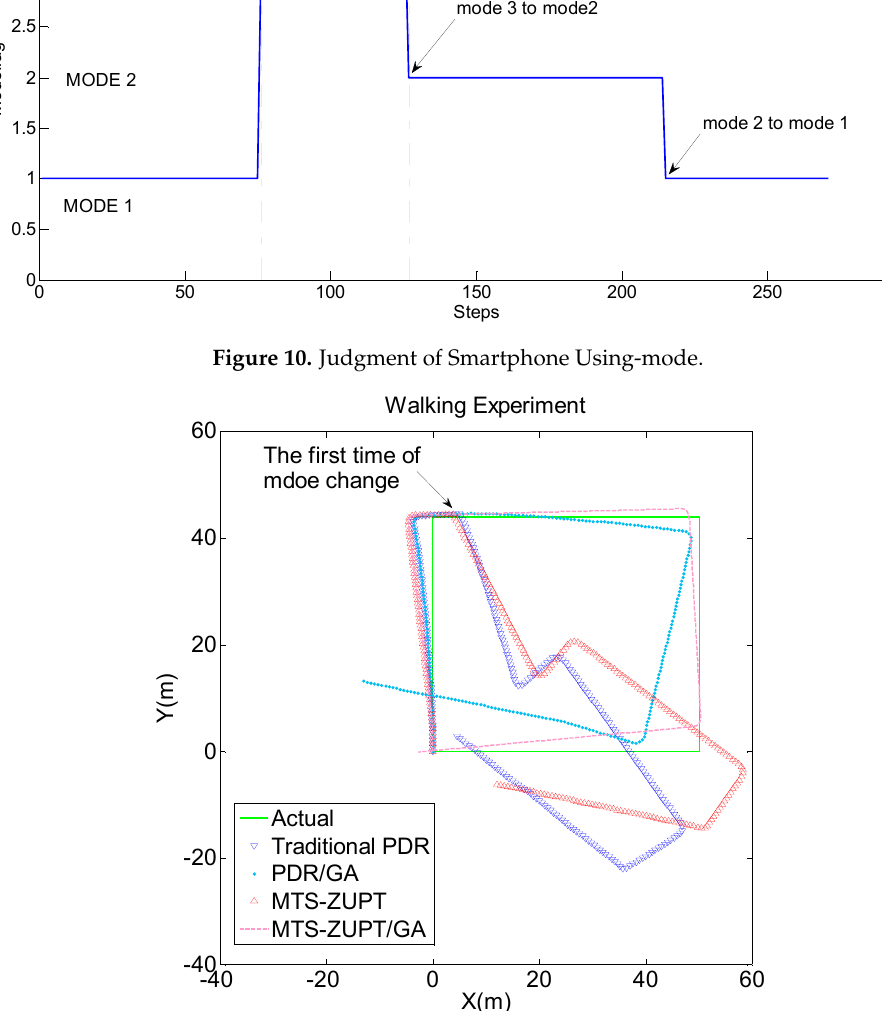
Figure 11. Walking Experiments Comparison.